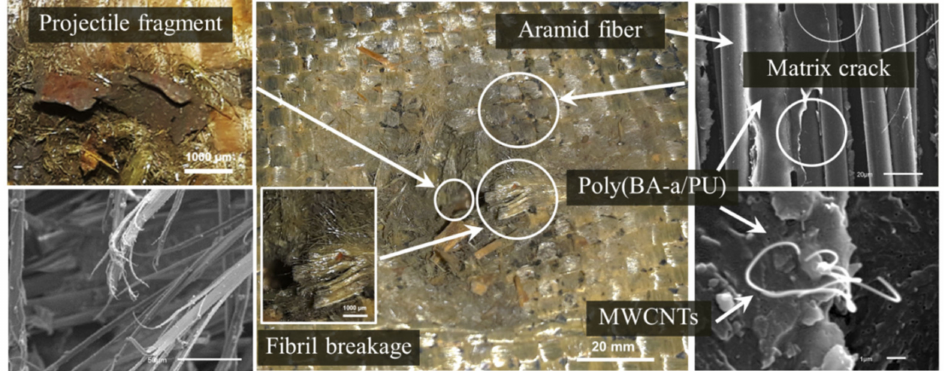
Figure 8. Ballistic-impact response of an aramid fabric-reinforced with a poly(BA-a/PU) composite containing 0.3 wt% of MWCNTs after being